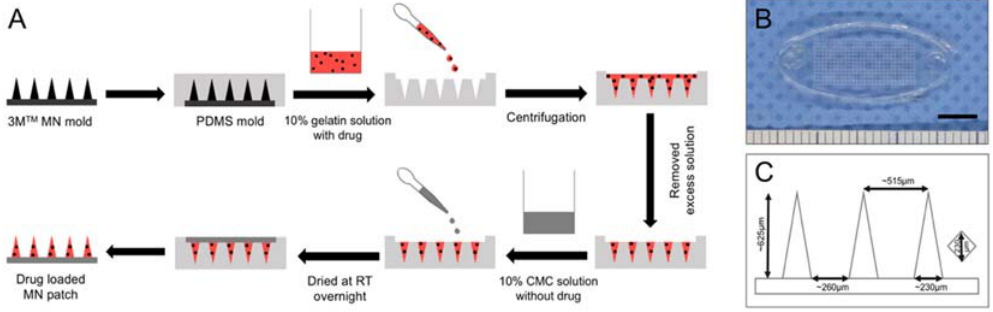
Figure 1. ( A ) Schematics of the fabrication process of dissolving gelatin/CMC MN patches. The drug was localized in the tip of the needles. ( B ) Gross view of the gelatin/CMC MN patch. Scale bar = 5 mm. ( C ) Average dimensions of geometrical parameters of gelatin/CMC MN patches.